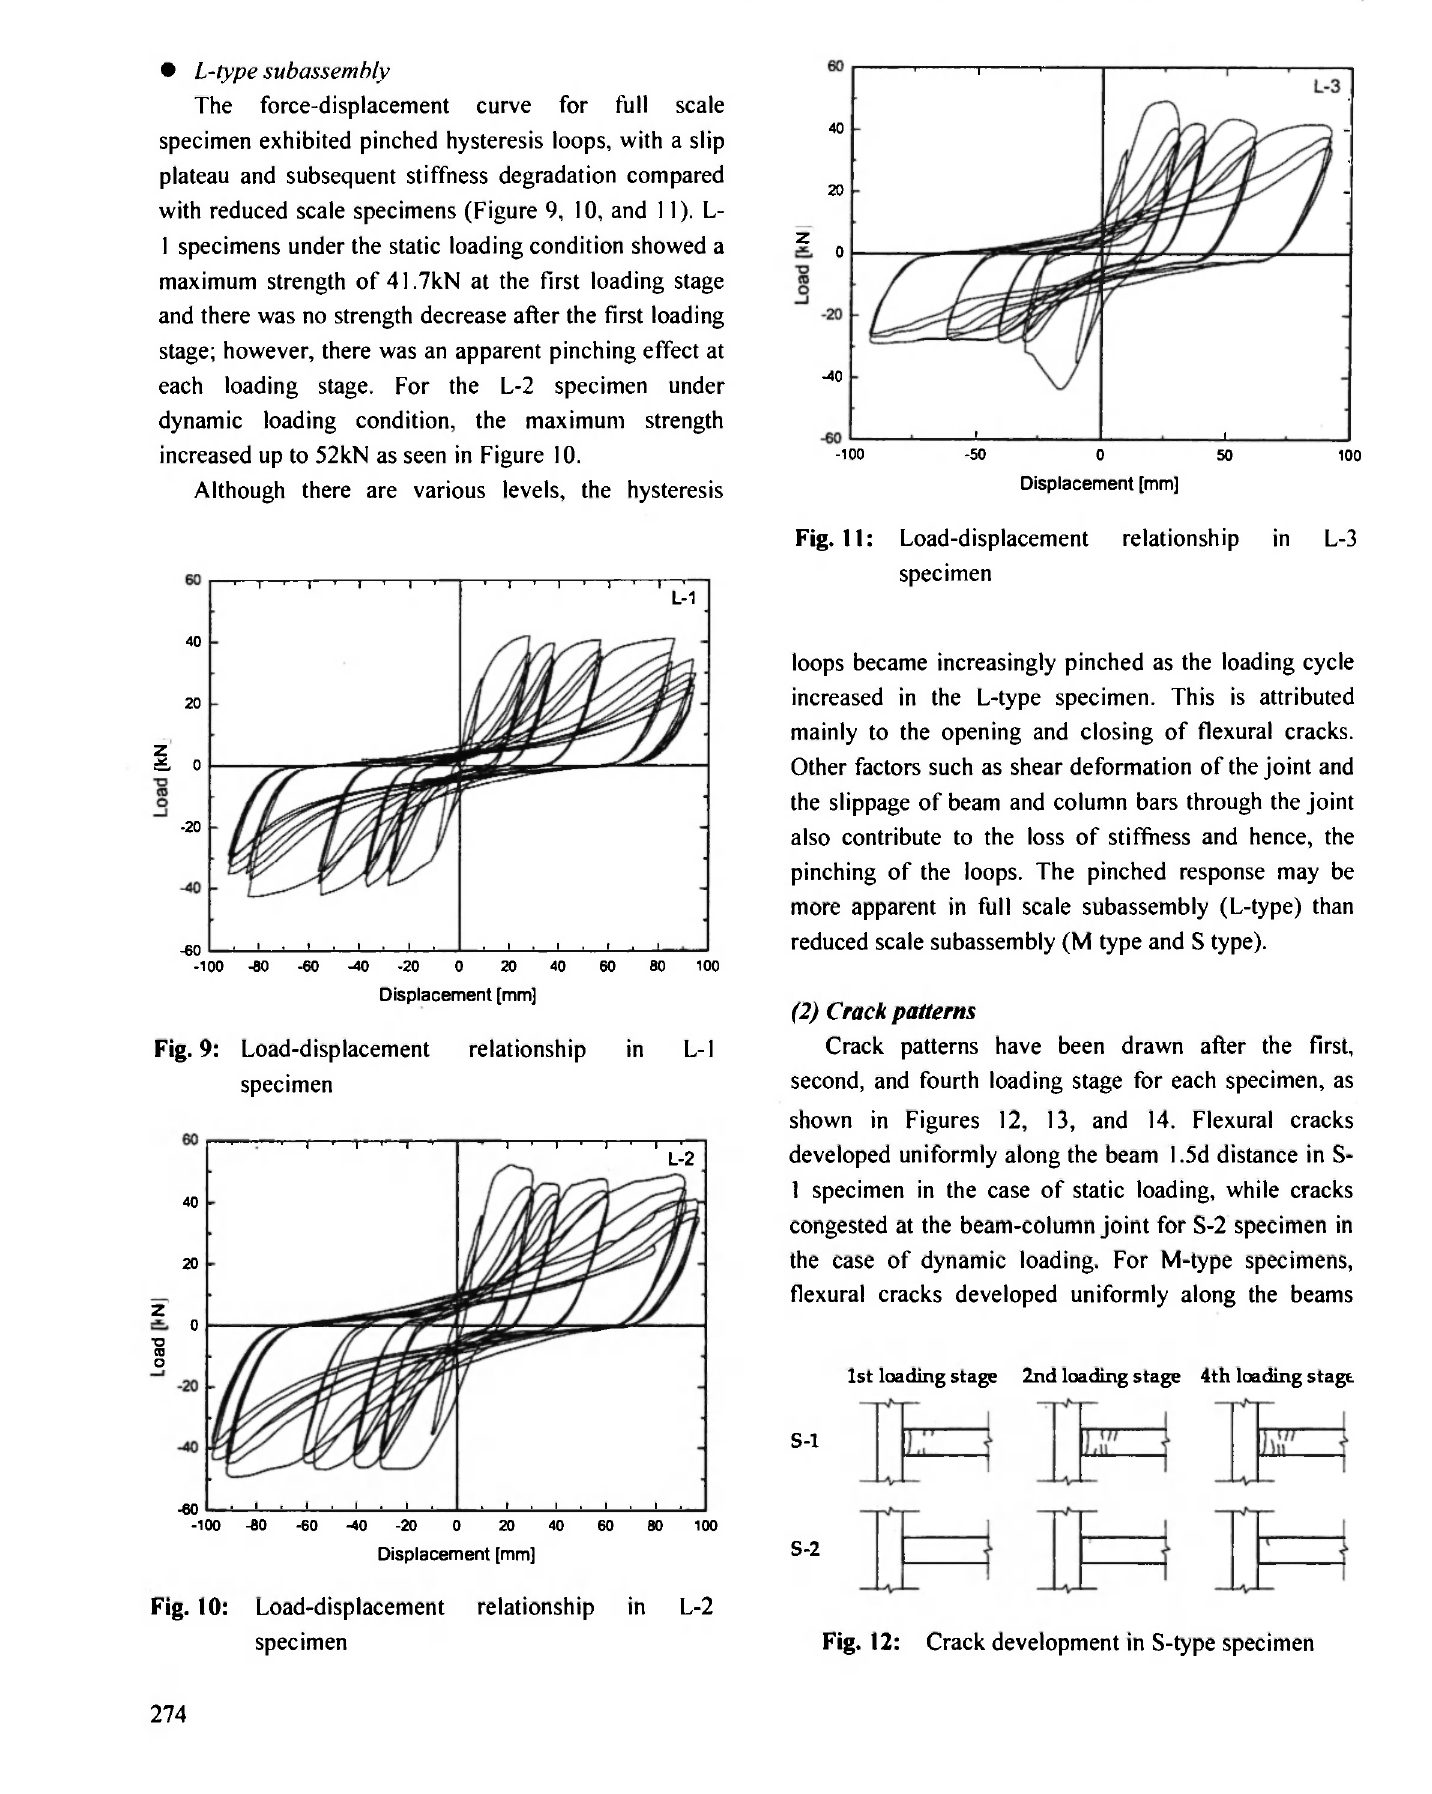
Fig. 12: Crack development in S-type